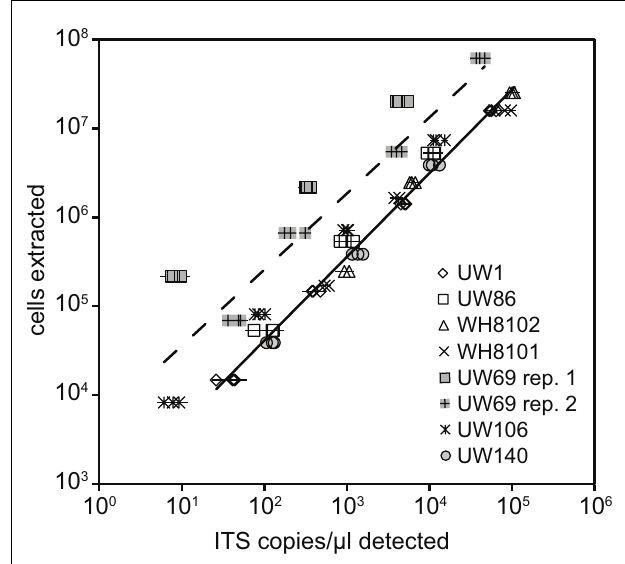
FIGURE 2 | Calibration of qPCR assays. Known amounts of cells from cultures were filtered and extracted for various strains. Extracted cells were plotted against the concentration of ITS copies/ μ l detected with qPCR using plasmid standards.Triplicate filters were made and extracted for each concentration of cells tested. Points represent averages of quadruplicate qPCR reactions performed on each extraction, and error bars represent the standard deviation. Log–log regression lines are shown for all clade XV strains tested (dashed line, UW69 both replicate filter sets and UW106) and all remaining strains together (solid line).